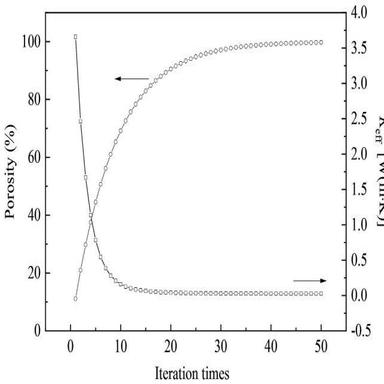
The relationship between the iteration times and porosity and thermal conductivity of MFWs fractal structure.